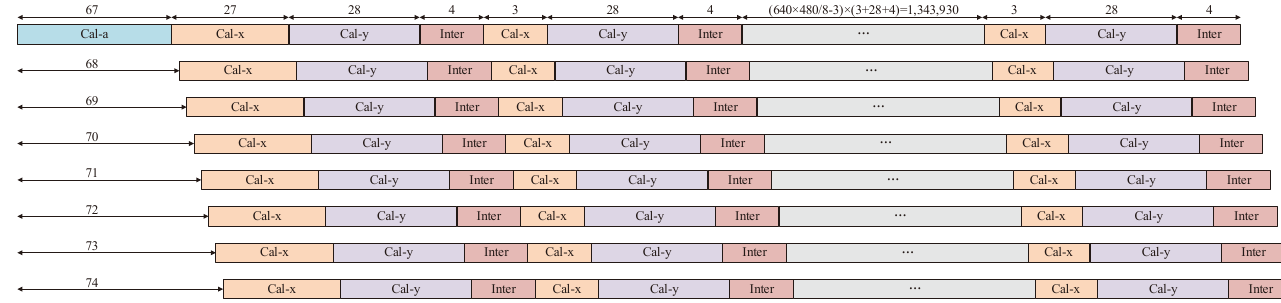
Figure 8. Timing diagram when parallelism is eight. Among them, Cal-a represents calculating a 0 and a 1 using the structure in Figure 3, Cal-x represents calculating x 0 and x 1 using the structure in Figure 5, Cal-y represents calculating y 0 and y 1 using the structure in Figure 6, and Inter represents the interpolation algorithm using the structure in Figure